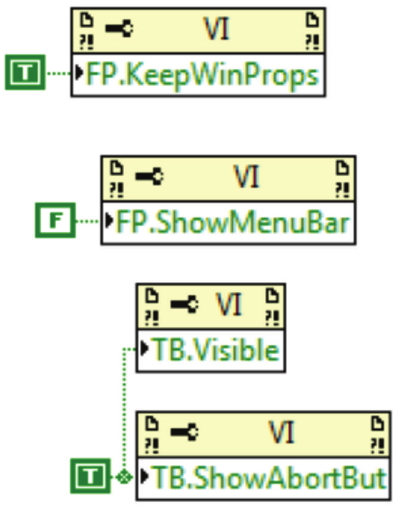
Figure 12: Programming block of the configuration